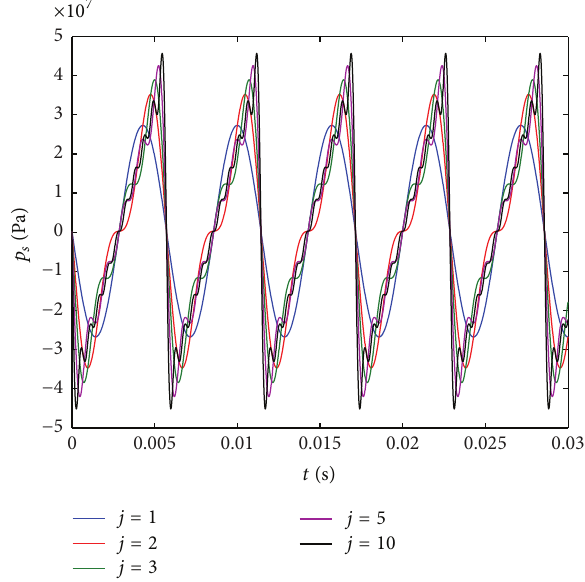
Figure 3: Pressure pulsation 𝑝 𝑠